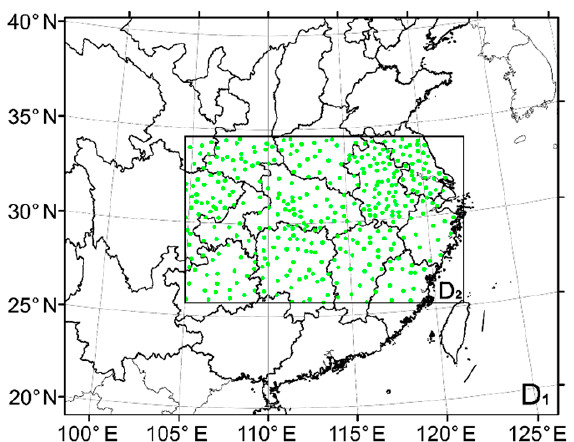
Figure 1. Simulation area and distribution of observation stations, where the domains D 1 and D 2 are designed for the simulation and the evaluation,